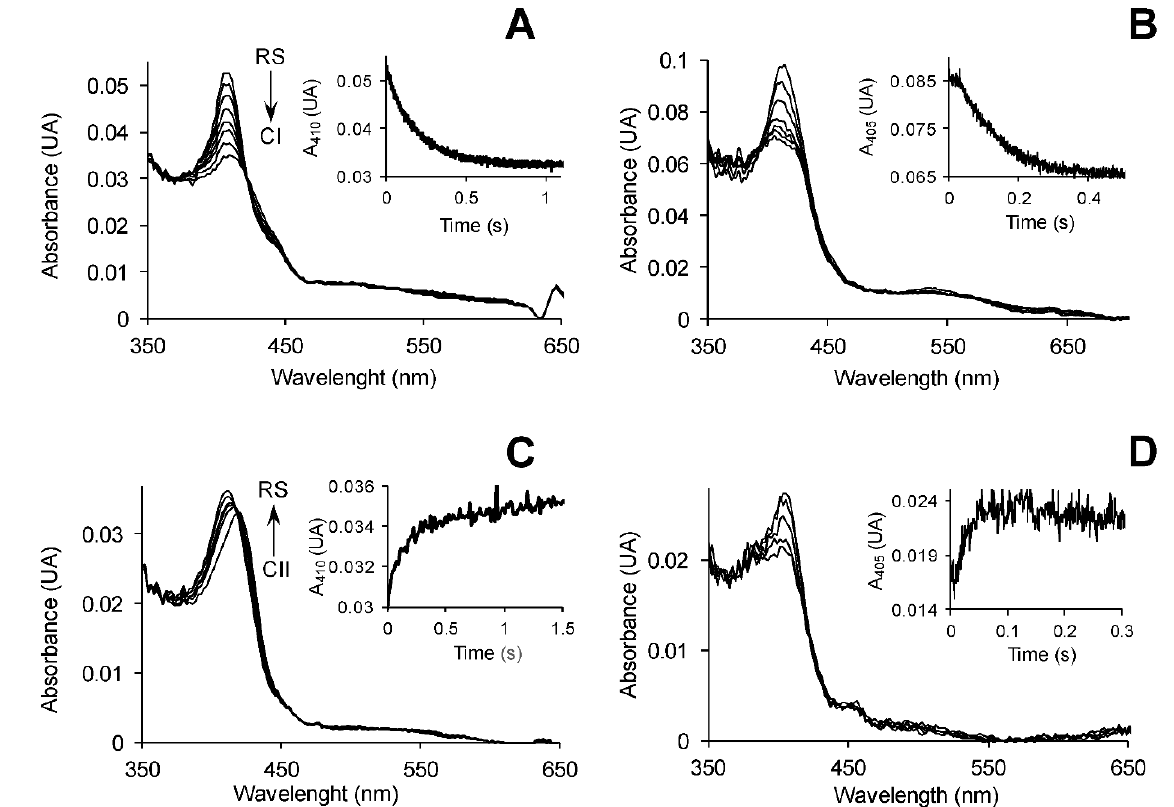
Figure 4. Four examples of stopped-flow measurements for E o ’ estimation of peroxidase catalytic couples. ( A , B ) Spectral changes during CI formation by H 2 O 2 addition to Pch LiPA and Asp DyP2, respectively. ( C , D ) Spectral changes upon reduction with tyrosine of the CII species formed by adding H 2 O 2 and one FeKCN equivalent to Pch LiPA and Asp DyP2, respectively. The arrows indicate the order of successive spectra from RS to CI and from CII to RS in ( A / B ) and ( C / D ), respectively. The insets show time traces near the Soret maximum (at 410 nm in ( A ) and ( C ), and 405 nm in ( B ) and ( D )) to attain equilibrium conditions. All reactions were at optimal pH 3, and 25 ◦